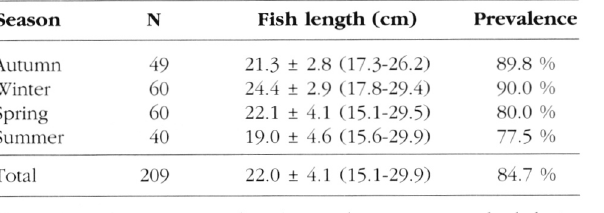
Table II. - Prevalence of Kudoa sp. infection in Trachurus trachurus captured in different seasons.